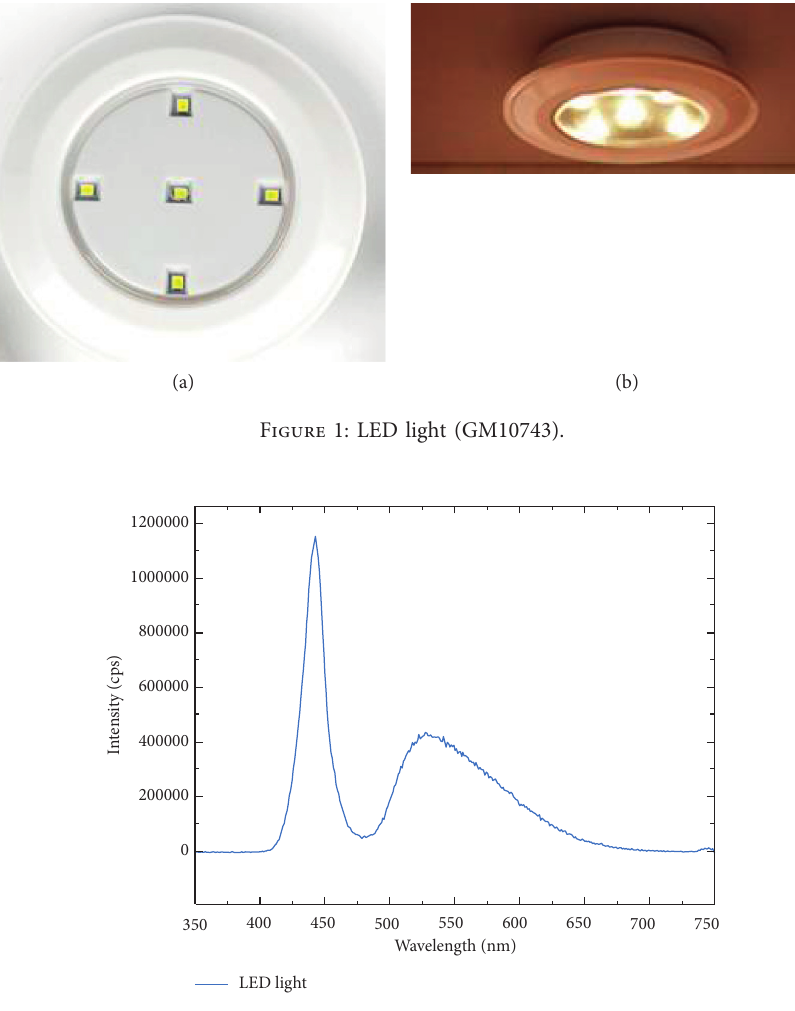
Figure 2: Spectral power